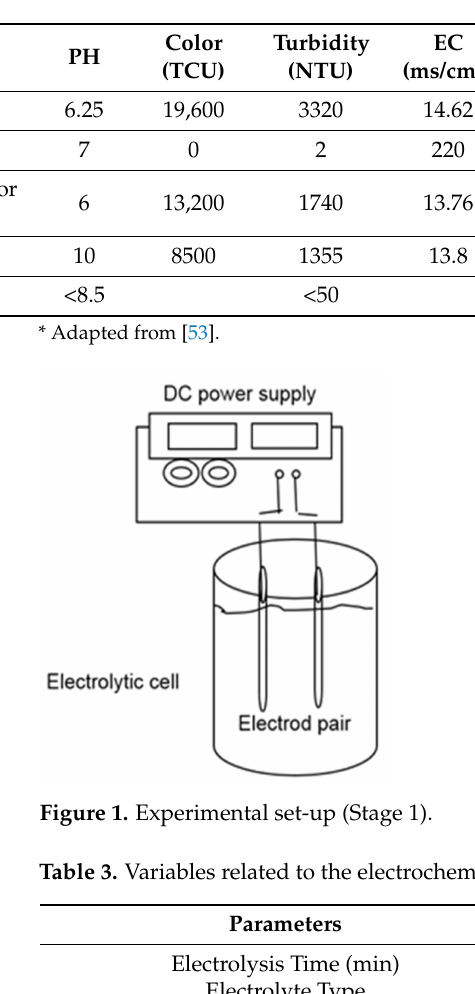
Table 2. The composition of raw leachate of Yasuj landfill site.